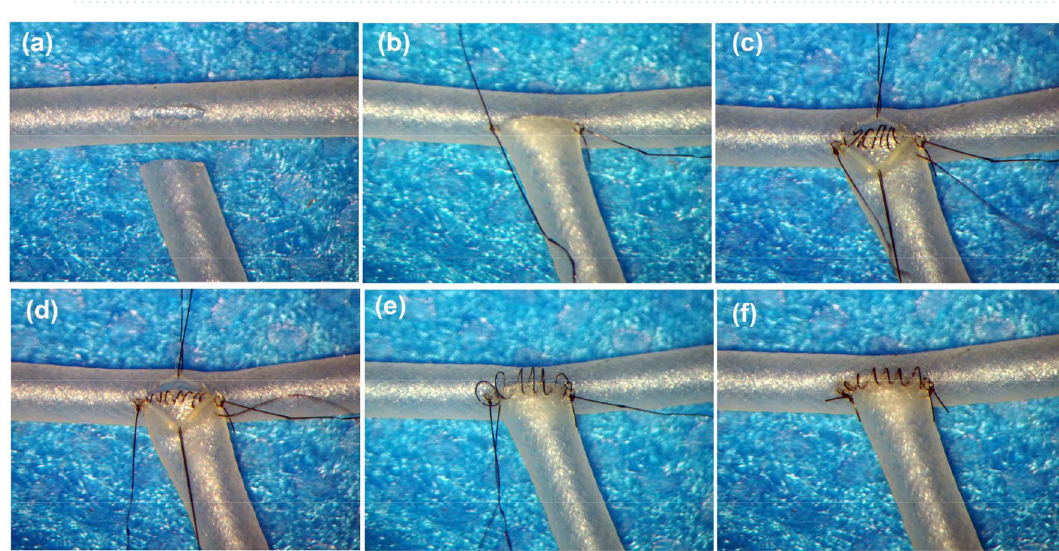
Figure 3. End-to-side anastomosis by using silicone tube. The end of the donor silicone tube was trimmed, and a same size of longitudinal incision was performed on the recipient silicone tube ( a ). The heel and toe stitches were placed ( b ). The posterior wall was closed intraluminally in a loose continuous suturing technique ( c ) and these sutures were tightened ( d ). The anterior wall was closed extraluminally in a loose continuous suturing fashion ( e ) and these sutures were tightened ( f